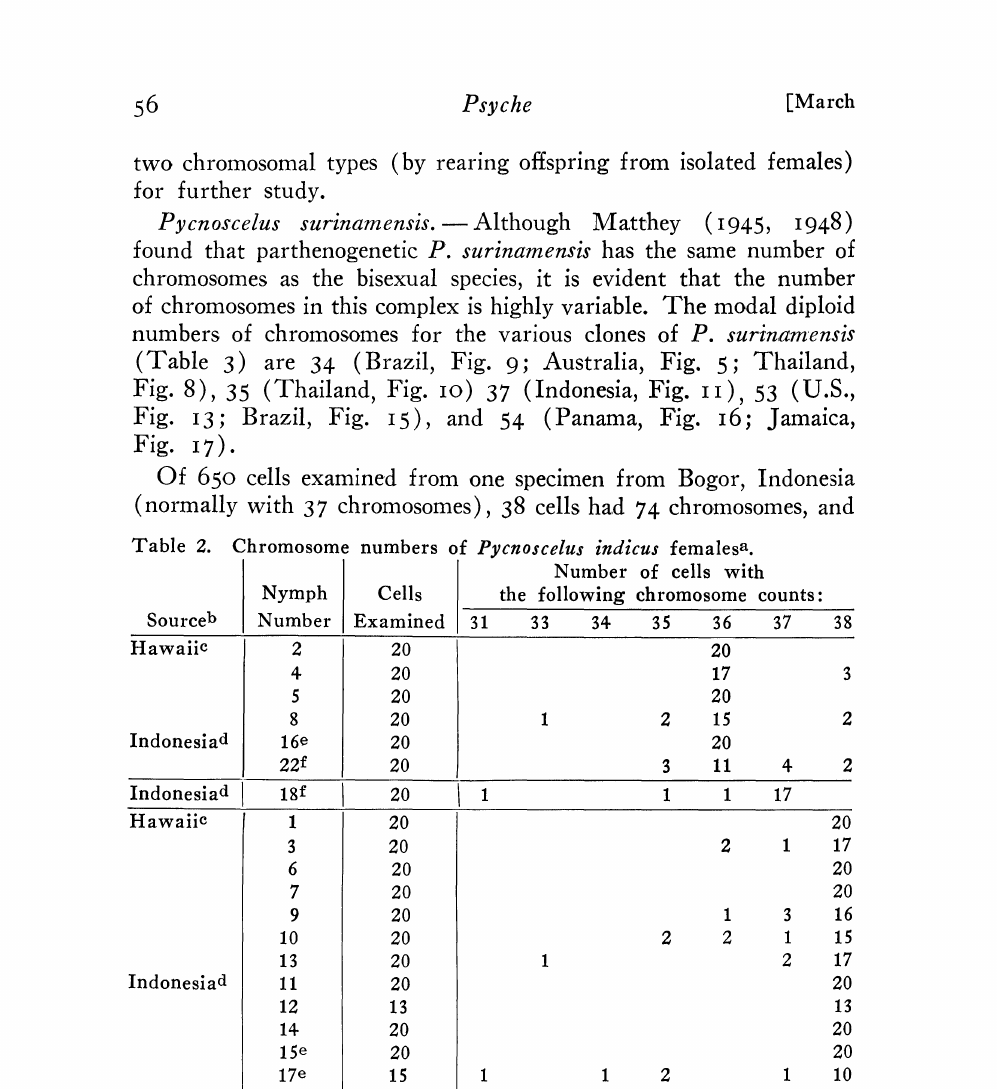
Chromosome numbers of Pycnoscelus indicus femalesa. Number of cells with Nymph Cells the following chromosome counts" Source b Number Examined